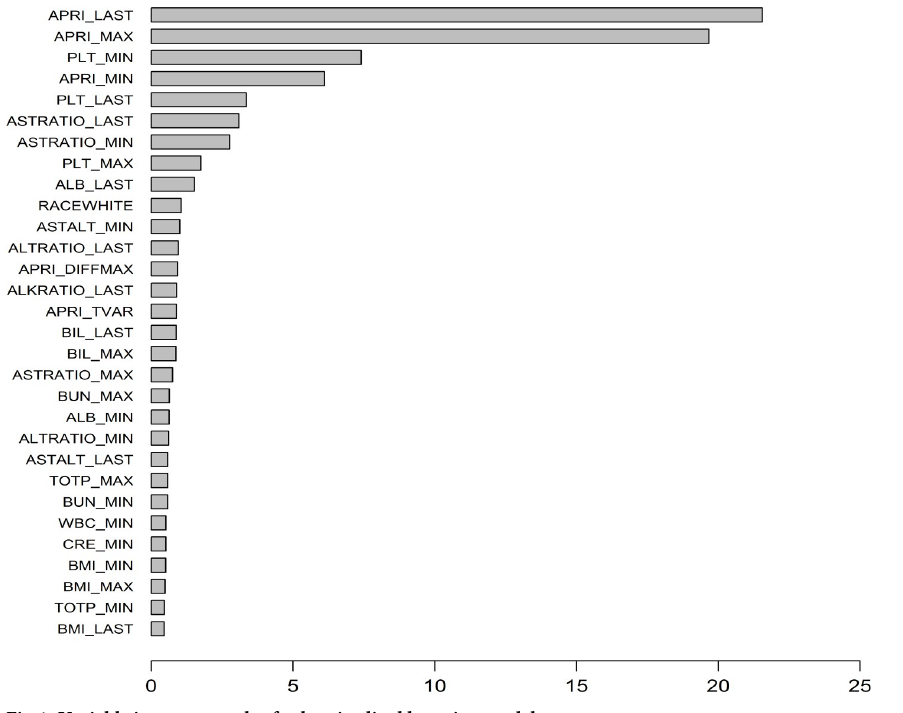
Fig 4. Variable importance plot for longitudinal boosting model.